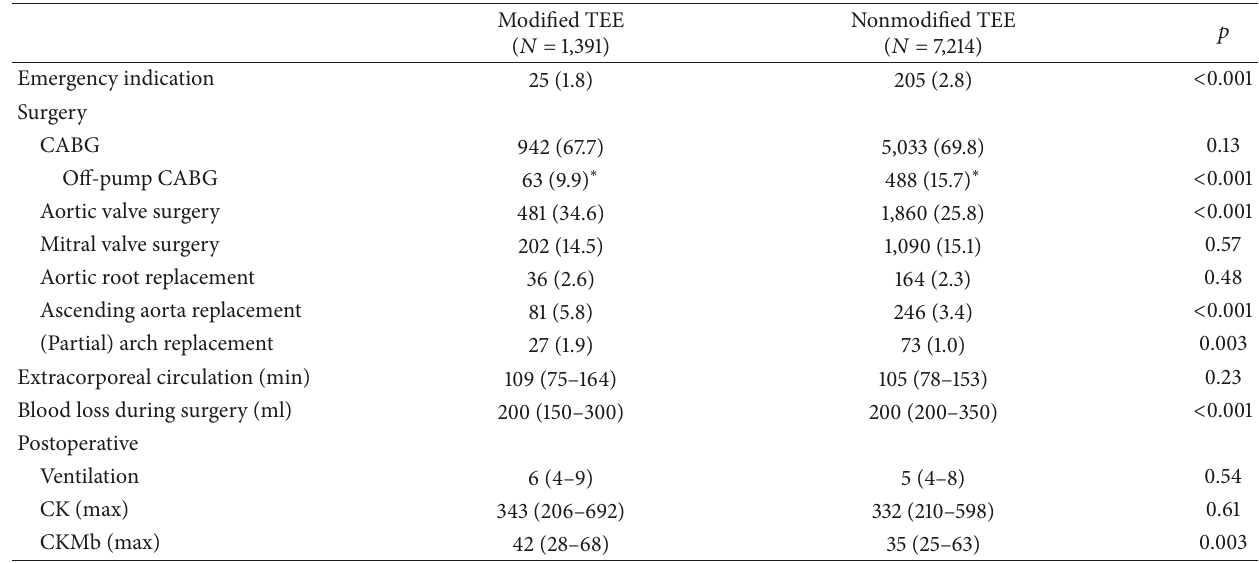
Table 3: Operative characteristics comparing patients with and without perioperative screening with modified TEE. ∗ Percentage of patients with isolated coronary revascularization. CABG = coronary artery bypass grafting, CK = Creatinin Kinase, and CKMb = Creatinin Kinase MB isoenzyme.